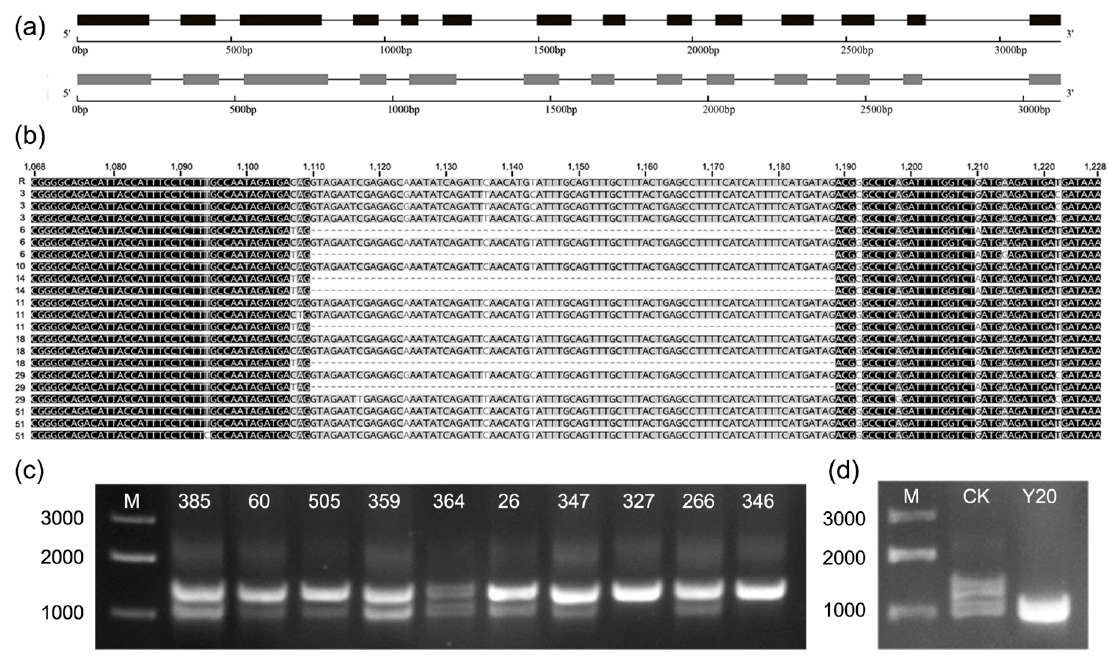
Figure 4. The two gene forms detected in the IbAGPb3 gene sequence. ( a ) Gene structure analysis of a 79-bp insertion and deletion form of IbAGPb3 . ( b ) Cloning and sequencing of the IbAGPb3 sequences in sweet potato germplasms. R: reference sequence; the numbers 3, 6, 10, 11, 14, 18, 29, and